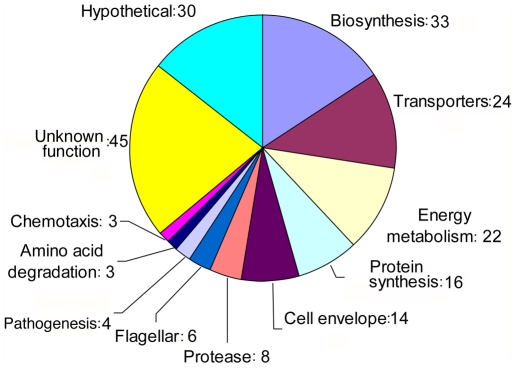
Functional categorization of C. jejuni proteins whose expression was lower in samples obtained 20 hours after infection.Proteins were assigned to the different functional groups based on genome annotation and additional curation based on published literature.